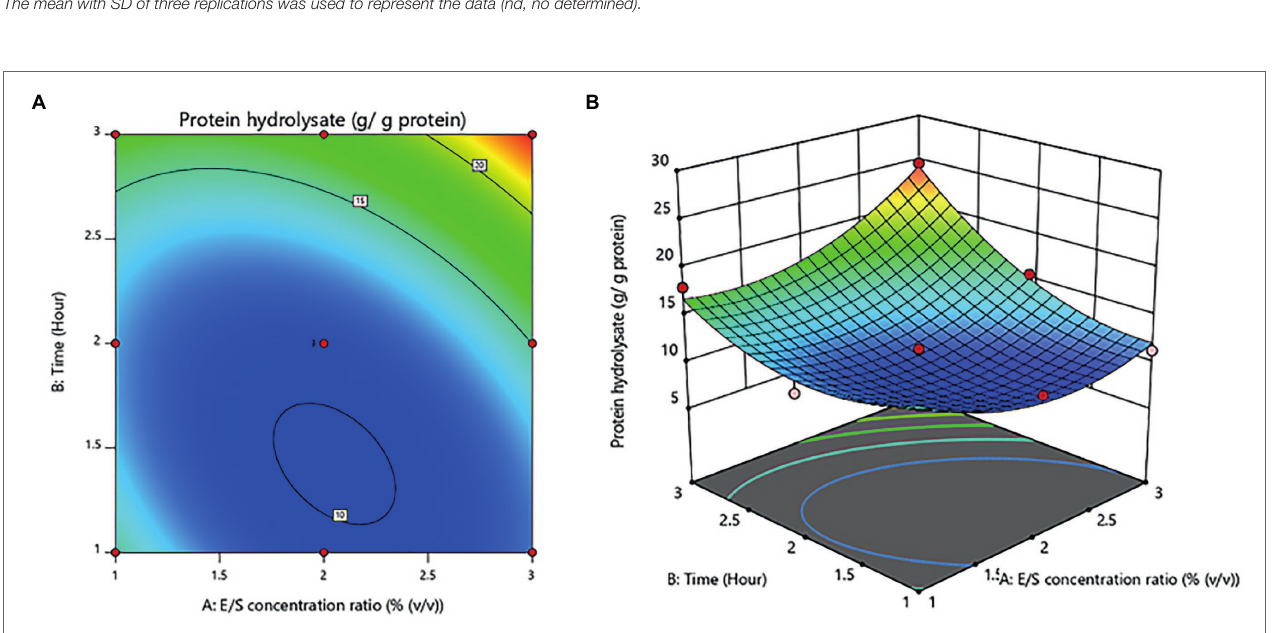
FIGURE 1 | Contour plot (A) and response surface plot (B) yield of protein hydrolysates as a function of enzyme/substrate concentration ratio and